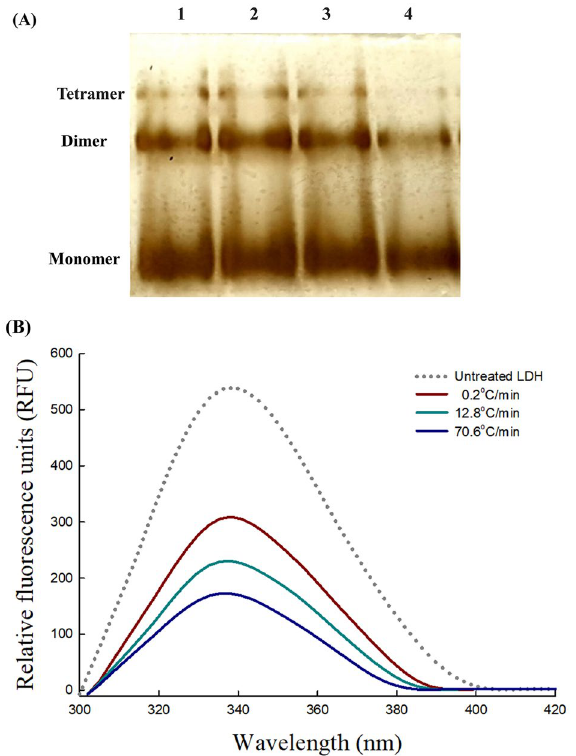
Figure 4. ( A ) Blue native-polyacrylamide gel electrophoresis profile of LDH after silver staining following the freeze–thaw process repeated five times. The concentration of the LDH solution was 40 μg/mL. Lane 1 was for untreated LDH, Lanes 2, 3, and 4 were for freeze-thawed LDH treated at freezing rates of 0.2, 12.8, and 70.6 °C/ min, respectively. The full-sized gel is presented in the supplemental information (Supplementary Fig. S2). ( B ) Intrinsic fluorescence emission spectra (300–420 nm) of 20 μg/mL LDH in 0.2 M Tris–HCl buffer (pH 7.4) after the freeze–thaw process was repeated five times. LDH solution was frozen at a freezing rate of 0.2, 12.8, or 70.6 ºC/min. The frozen samples were thawed in a water bath at 25 ºC for 5 min before